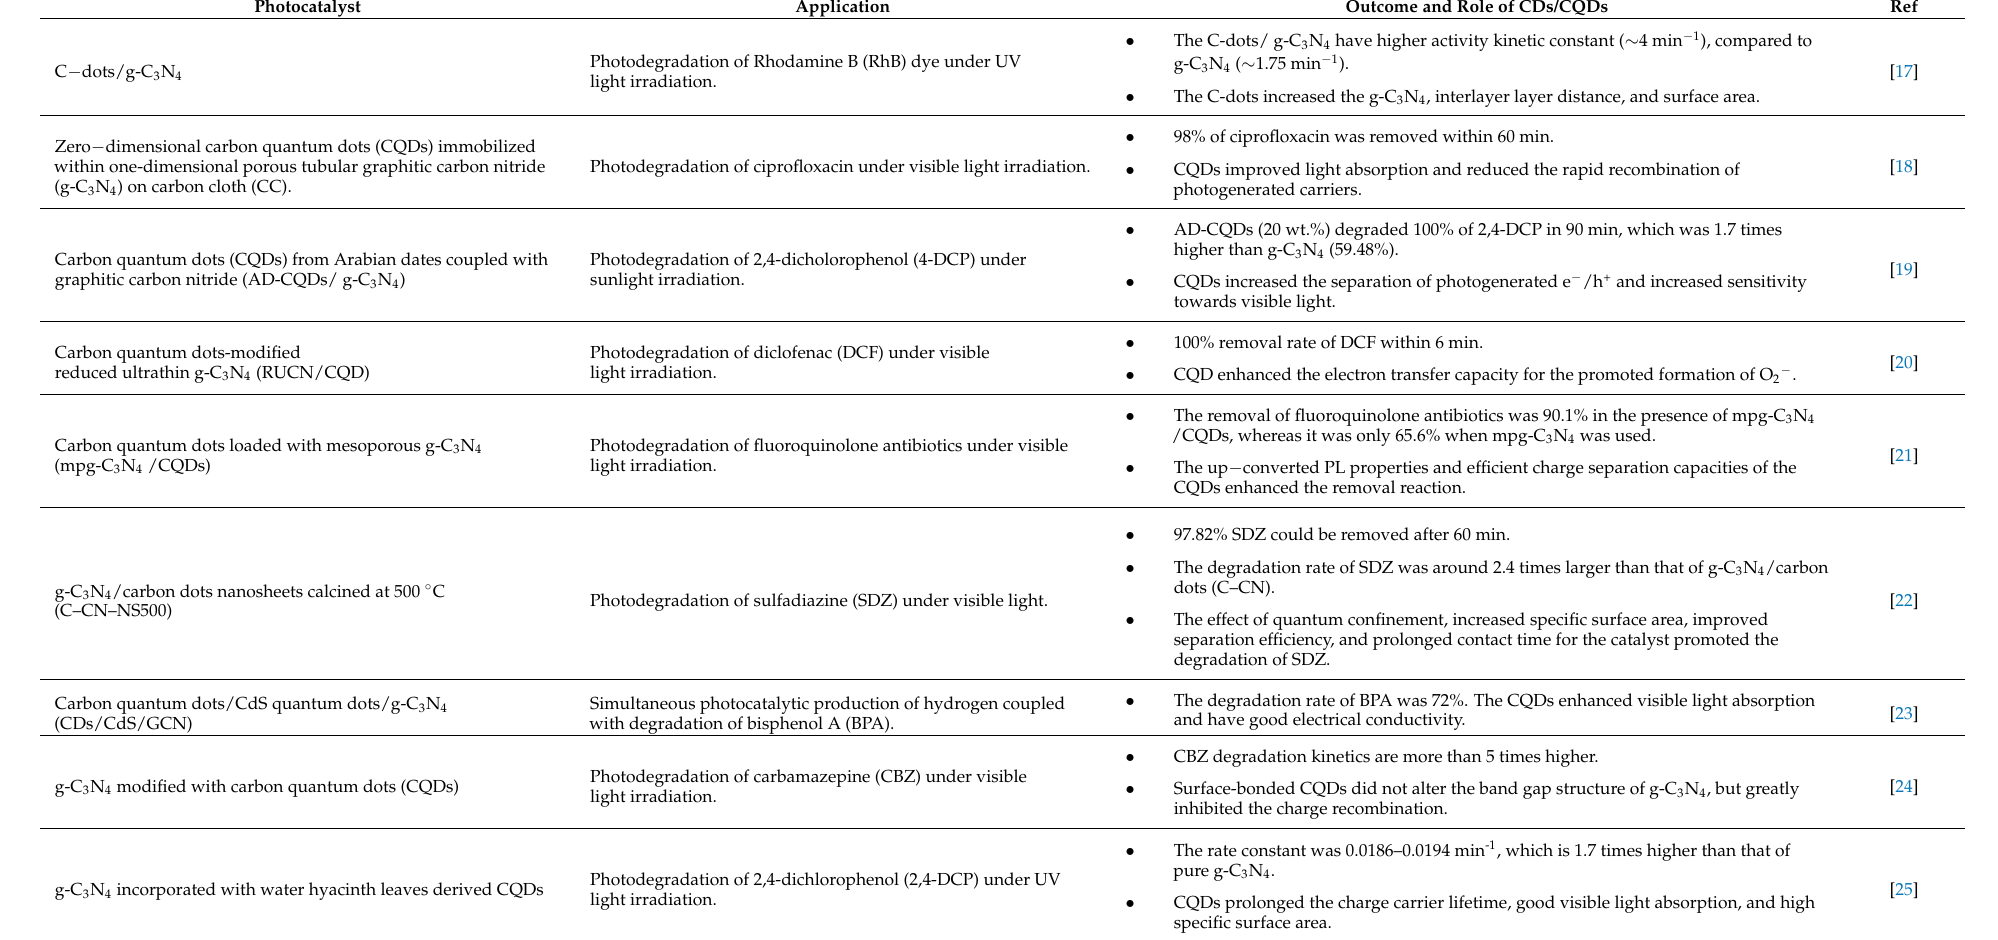
Table 1. Graphitic carbon nitride (g-C 3 N 4 ) modified carbon quantum dots for various organic